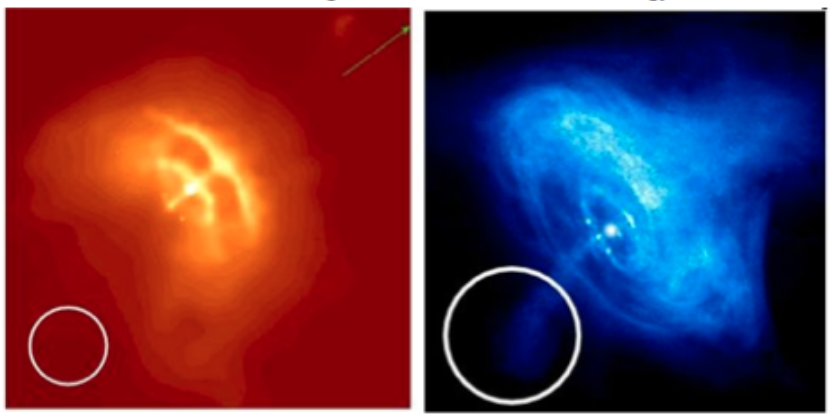
Figure 1. Chandra images of the Vela ( left ) and Crab ( right ) PWNs. The IXPE 30” resolution (half power diameter) is shown in the lower left corners of the images. From the IXPE Science-Investigation Document.